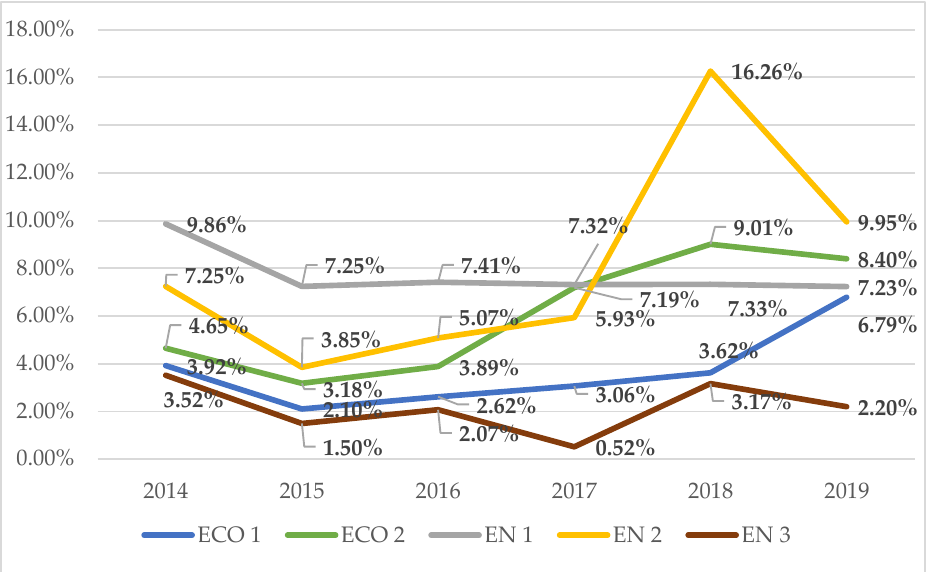
Figure 3. ROE at the surveyed research institutes in 2014 – 2019. Source: own compilation based on the financial statements.